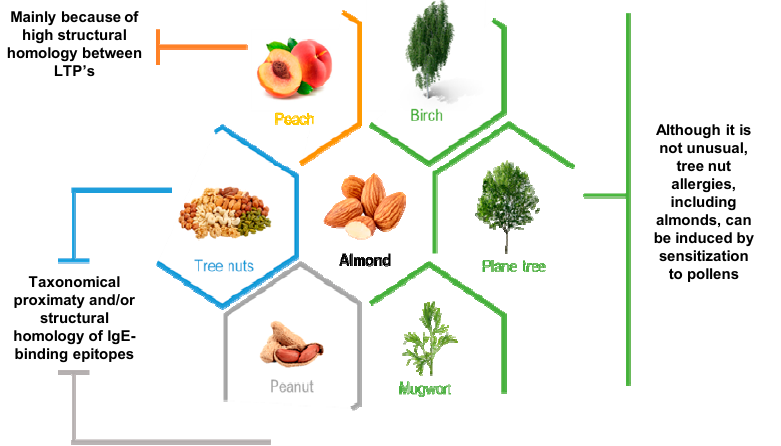
Figure 2. Most associated allergic cross-reactions with almonds. In orange, allergic cross reactions between almonds and peaches are most commonly due to high structural homology between allergic LTP’s present in the Rosaceae family that both belong to; in blue and grey, it is still unclear if cross reactivity between almonds and other tree nuts groups and peanuts is a consequence of taxonomical proximity and/or high structural homology of IgE-binding epitopes; finally, in green are represented three different pollens which, although it is not usual, when sensitized to them allergies to tree nuts such as almonds could be induced.